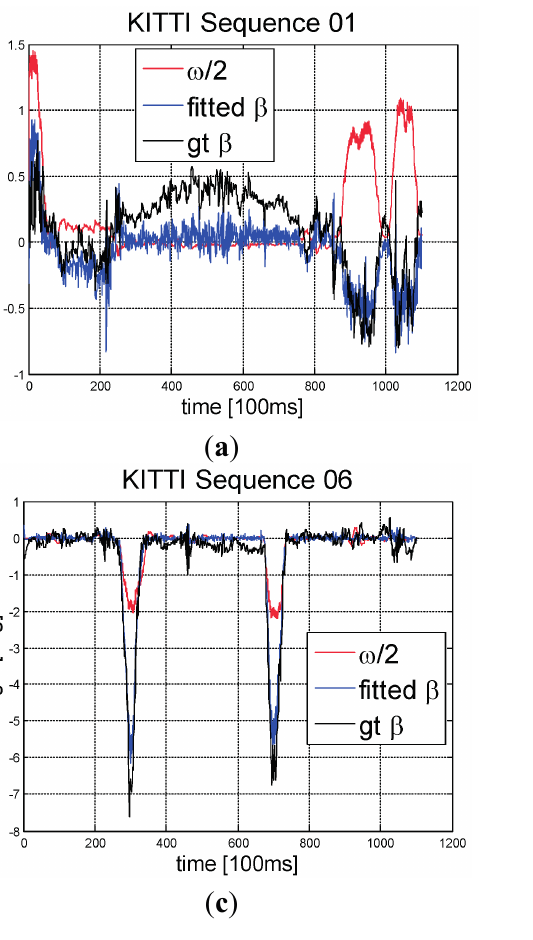
Figure 7. Fitted side slip angle using trained parameters: gt denotes ground